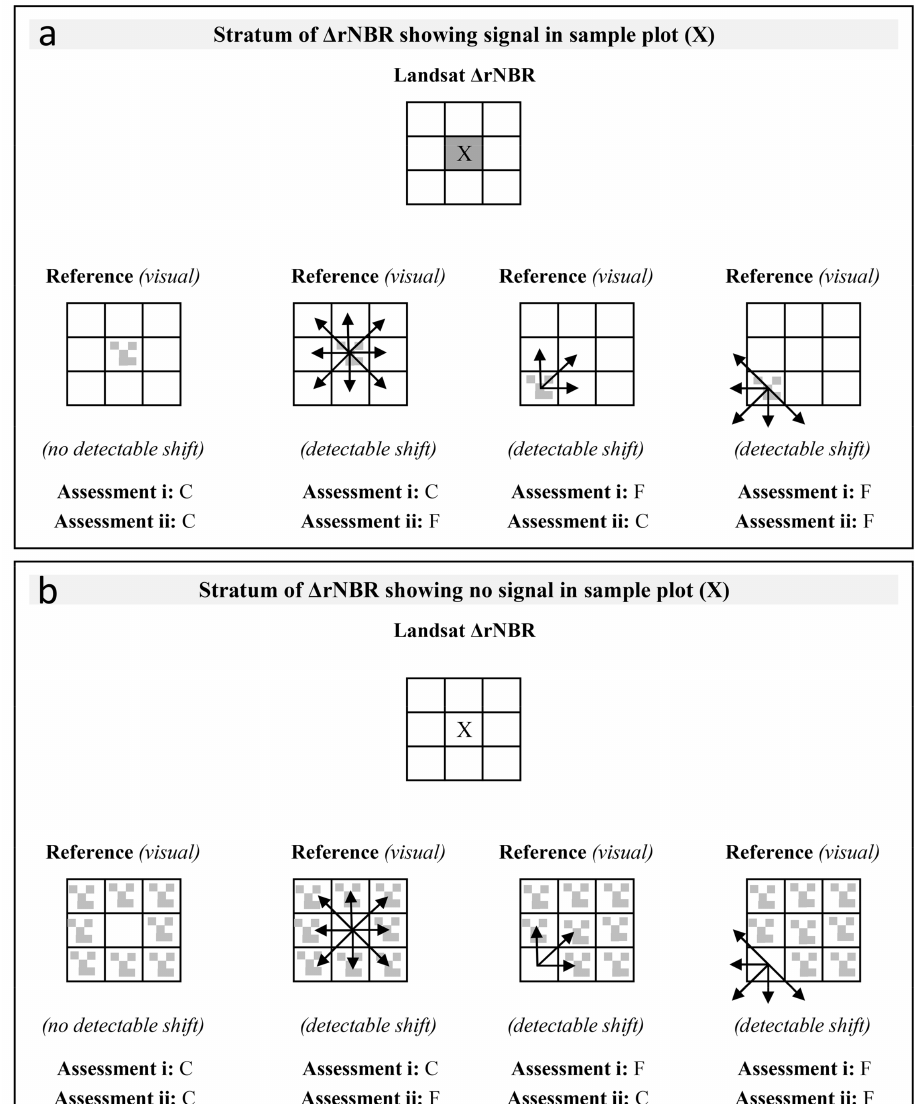
Figure 3. Visualization of the basic concepts of accuracy assessments applied in this study. ( a ) Handling of sampling plot with ∆ rNBR showing disturbance signal. ( b ) Handling of sampling plot with ∆ rNBR showing no disturbance signal. Grey cells = change in canopy cover; arrows = possible shifts in reference datasets or shifts relative to ∆ rNBR; C = correct assessment result; F = false assessment